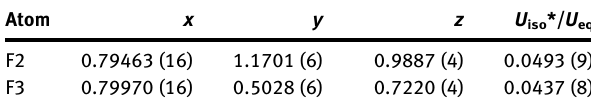
crude product. The crude product was poured into water (30 mL) and extracted with EtOAc (50 mL * 3). The EtOAc solvent was evaporated to provide the title compound as crystals suitable for X-ray diffraction analysis in 95.3% yield. 1